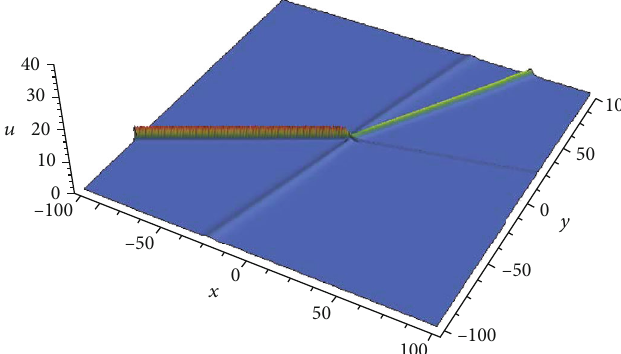
0 Þ = 0 , ξ ð 0 Þ = 0 , and ξ ð 0 Þ = 0 . 1 2 3